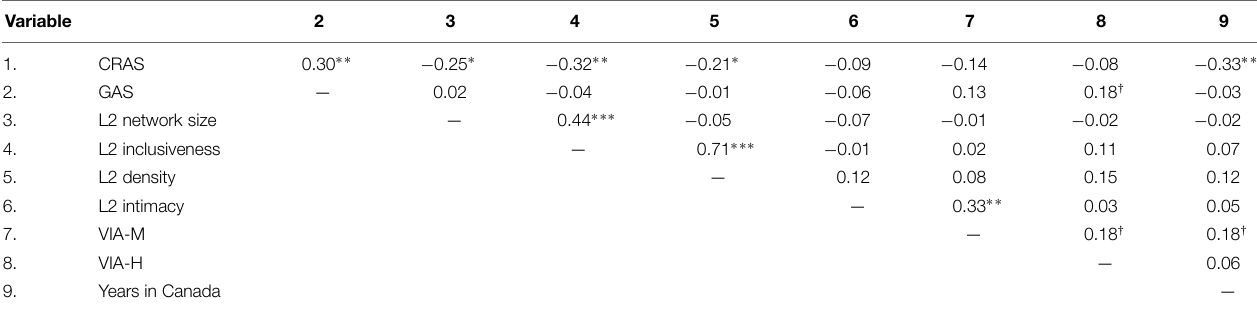
TABLE 1 | Zero-order intercorrelations of continuous study variables.